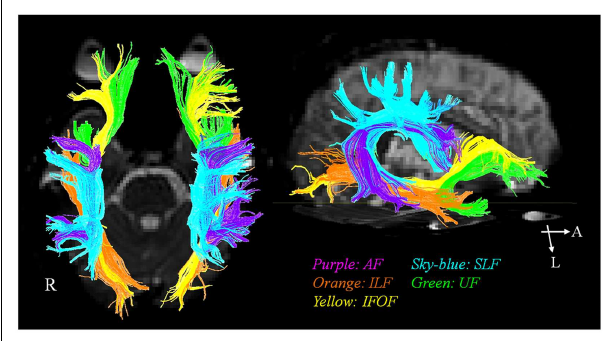
FIGURE 1 |The diffusion tensor tractographies of neural tracts for language: the arcuate fasciculus (AF), the superior longitudinal fasciculus (SLF), the inferior longitudinal fasciculus (ILF), the uncinate fasciculus (UF), and inferior fronto-occipital fasciculus (IFOF)